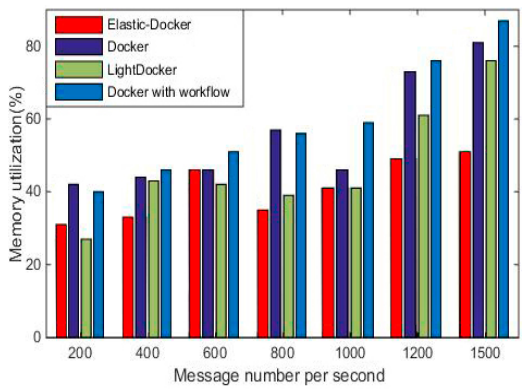
Figure 12. Comparison of memory consumption.